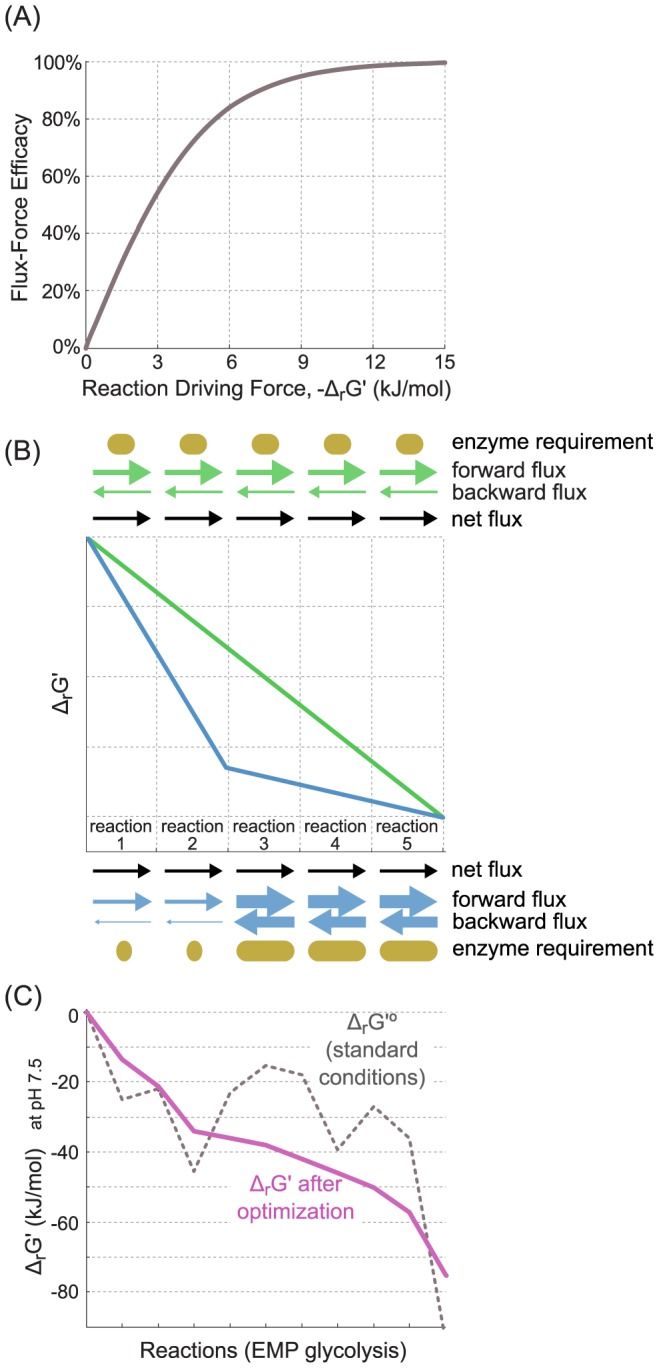
The Flux-Force Efficacy and Minimum Optimized Driving-Force (MDF).(A) A functional relationship between the reaction driving force (−ΔrG′) and its Flux-Force Efficacy, as described in detail in the Methods section. (B) Schematic comparison between two pathways. Each pathway starts and ends with the same compounds, employs five enzymes and carries the same net flux. The kinetic parameters of all enzymes in both pathways, as well as enzyme and metabolite concentrations, are assumed to be identical. (C) Energetic profile of Embden-Meyerhof-Parnas glycolysis. Dashed black line corresponds to ΔrG′o values (metabolite concentrations of 1 M) of pathway reactions at pH 7.5. Red line corresponds to ΔrG′ values of pathway reactions after an optimization procedure that maximizes the driving force of the reactions having the lowest driving forces, as described in the Methods section.